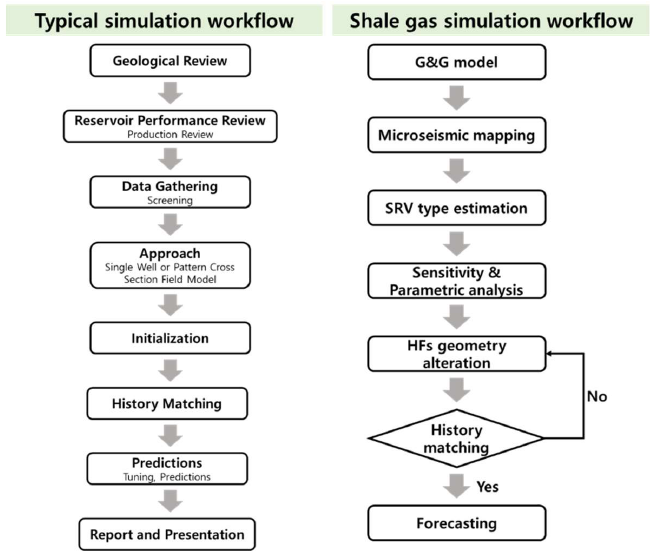
Figure 5. Workflows for typical geological simulations and shale gas simulation workflow [31,32]. Reproduced from [31,32], Ertekin: 2001, Carlson: